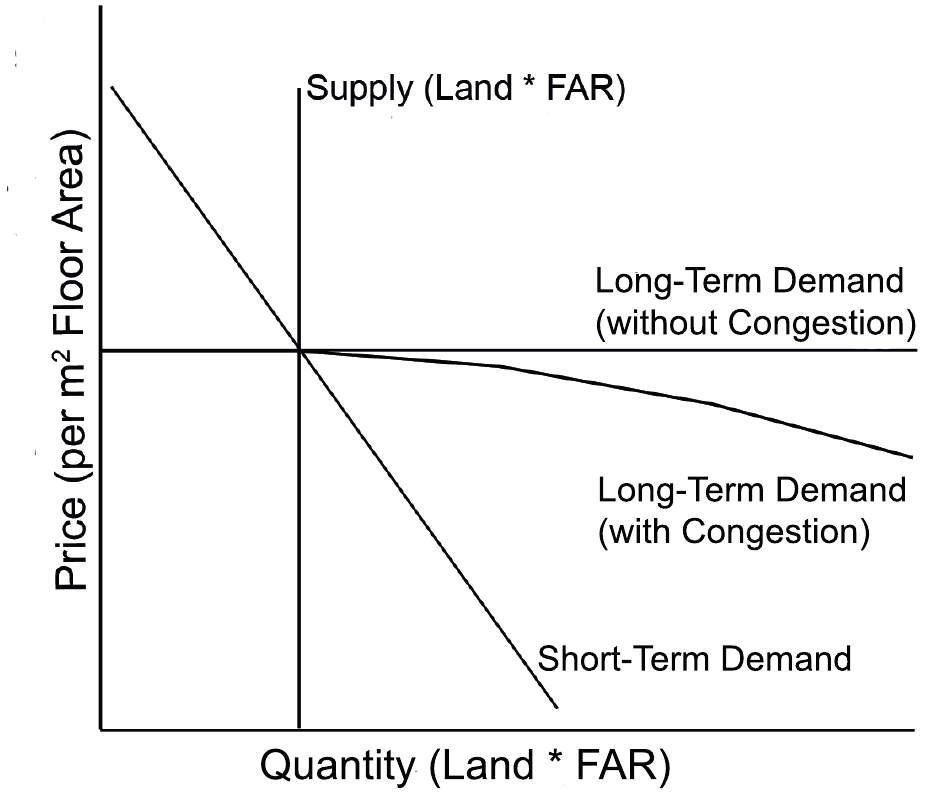
Figure 1. Short- and Long-Term Demand for Floor Area. (This figure shows the relationship between the price and quantity of land. In a homogeneous, regional housing market, the short-term demand for residential floor is assumed to be unit elastic, while the long-term demand is perfectly elastic. The introduction of negative externalities by accounting for the price elasticity of land with respect to the maximum allowed floor area ratio ( FAR ) affects the long-term demand negatively. It follows that a change in the FAR directly capitalizes into land values due to its decreasing marginal